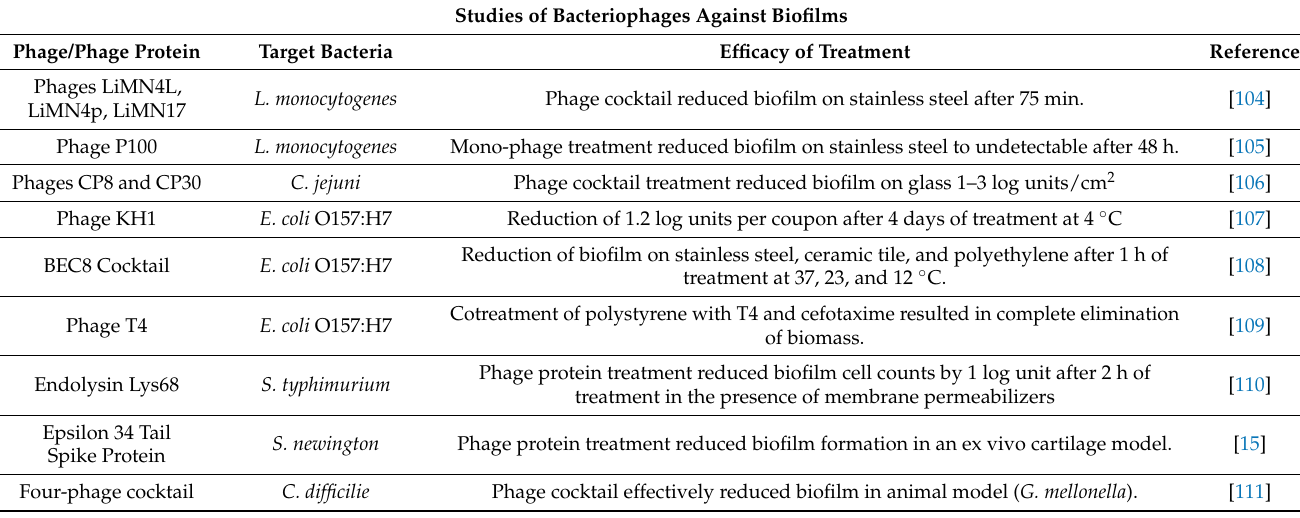
Table 3. Brief overview of bacteriophages against